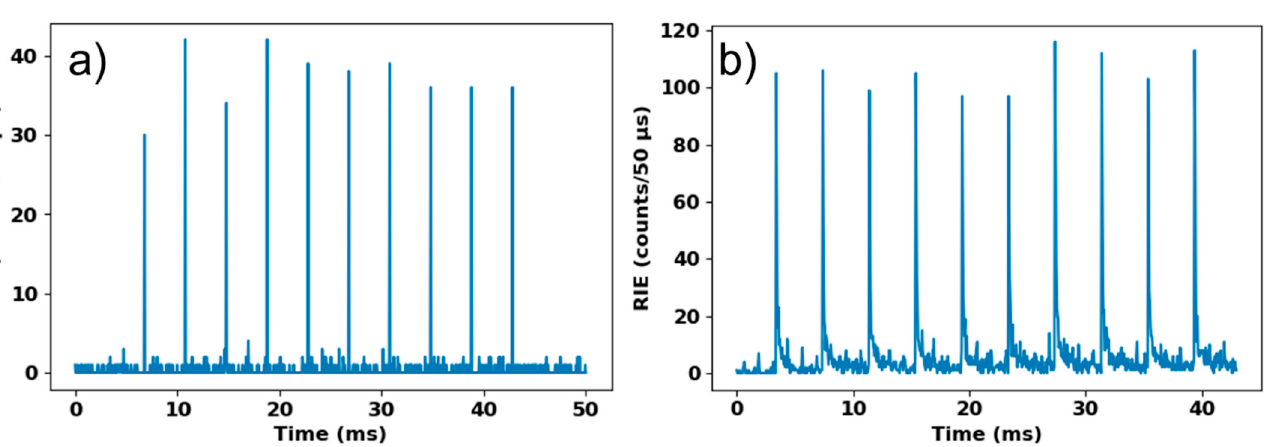
different steps. The first one was the electronic noise of the PMT. The second part con ‐ these peaks exhibited small amplitude, since there was only the small Cerenkov emission.